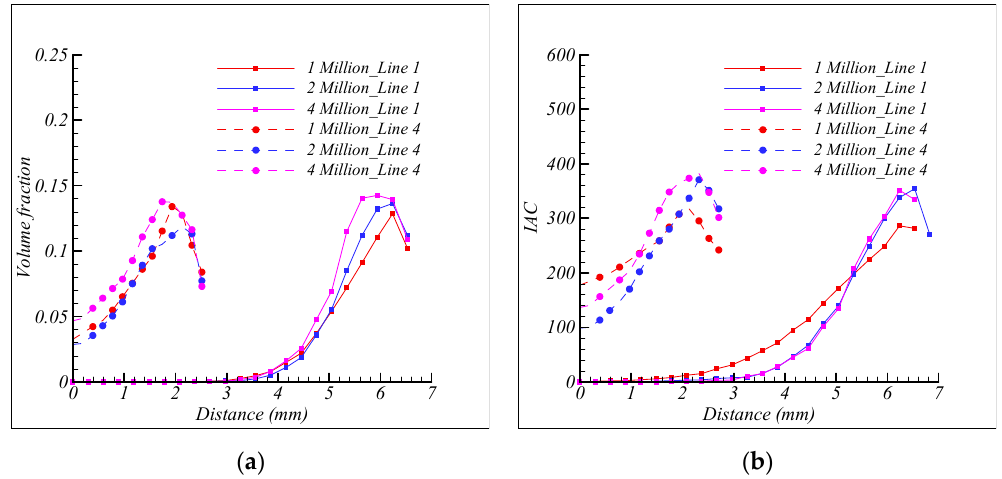
Figure 4. Comparison of one million, two million, and four million grids for tests on Lines 1 and 4: ( a ) volume fraction and ( b ) interfacial area concentration.